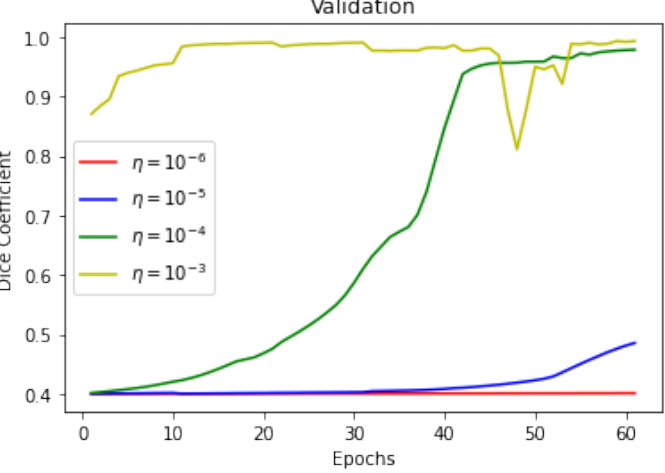
Figure 16. Validation Dice Coefficient with Different Learning Rates.